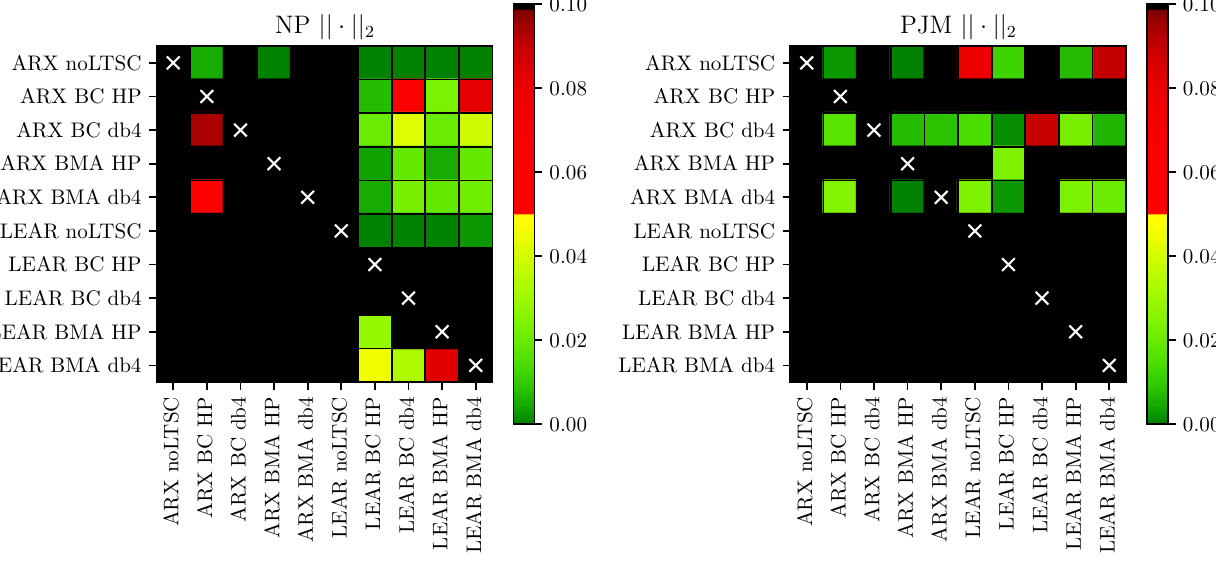
Figure 8. Results of the CPA test [32] for squared losses. A colored square (other than black) indicates that the predictions of the model on the x-axis are significantly better than the predictions of the model on the y-axis, at a given significance